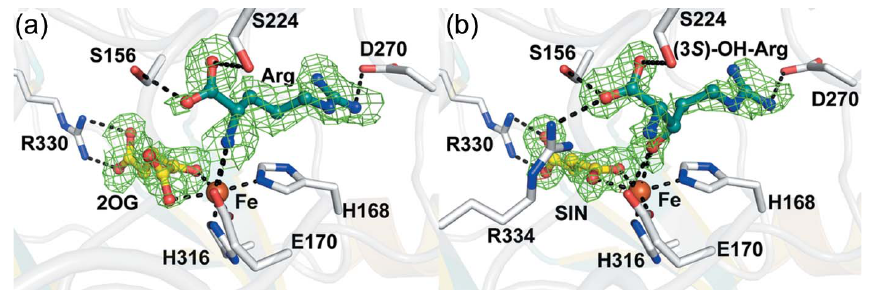
Figure 4 Comparison of the anaerobic and O 2 -exposed VioC structures. Close-up views of ( a ) a Polder omit map to 1.86 A ˚ resolution of the active site of the VioC:Fe:2OG:Arg substrate complex structure reported in this study (PDB entry 6y0n) displayed at 2.0 (cid:5) contour level, carved around the omitted arginine and 2OG, and ( b ) a Polder omit map of the active site of the VioC:Fe:2OG:(3S)-OH-Arg complex reported in this study (PDB entry 6y12) displayed at 3.0 (cid:5) contour level, carved around the omitted (3S)-OH-Arg product and succinate highlighting the coordination of the substrate and product of VioC via D270, E170, Fe, S224, S156 and the conformationally flexible residue R334, which is solely present in the (3S)-OH-Arg product complex and disordered in the VioC:Fe:2OG:Arg substrate complex (Mitchell et al. , 2017). (3S)-OH-Arg = (3S)-hydroxy-l-Arg; SIN =